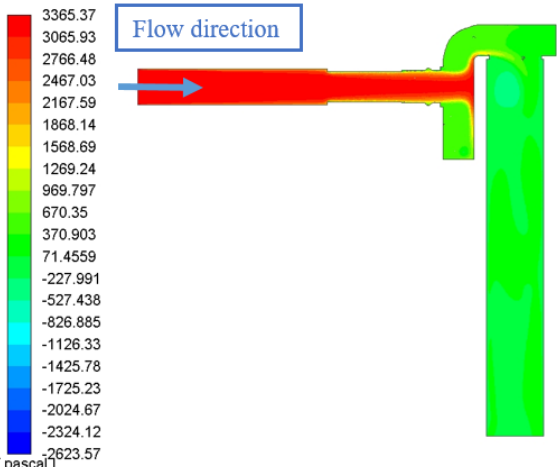
Fig. 4. Contours of Total pressure p / Pa